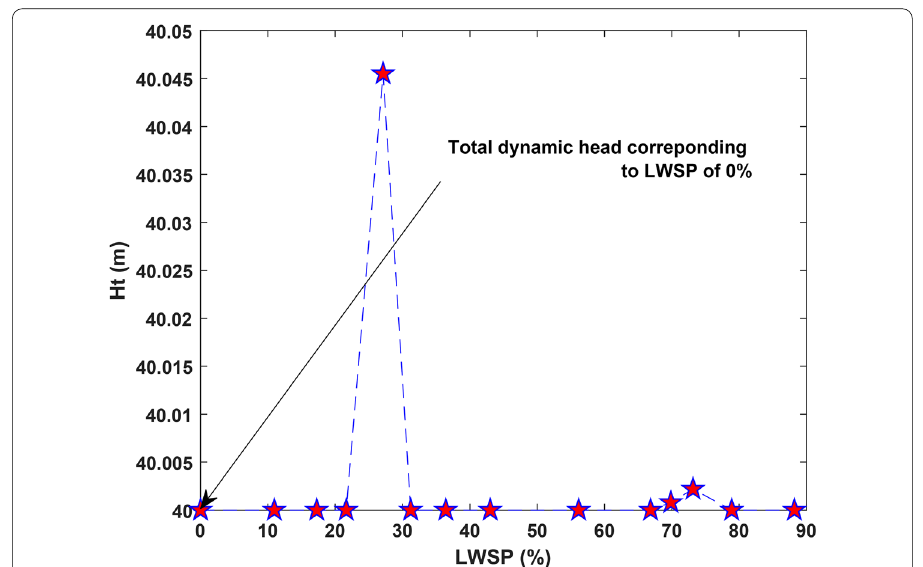
Fig. 9 Variation in the total dynamic head on Pareto front